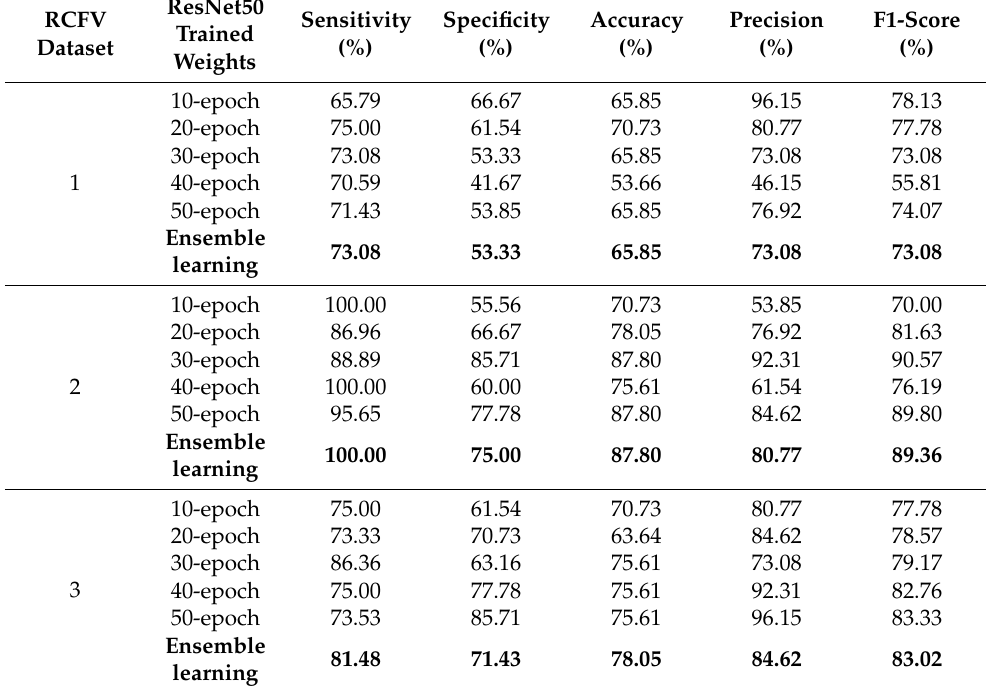
Table 11. The ResNet50 performances of specified weights with ensemble learning.